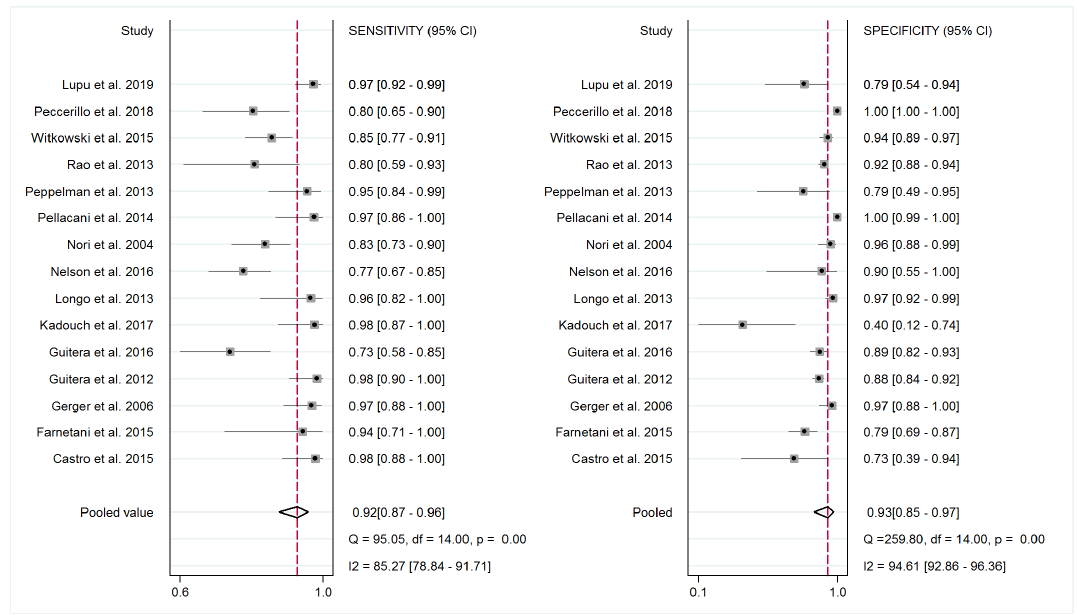
Figure 4. Forest plots for individual studies and pooled estimates of sensitivity and specificity with corresponding heterogeneity statistics of reflectance confocal microscopy for the diagnosis of basal cell carcinoma.